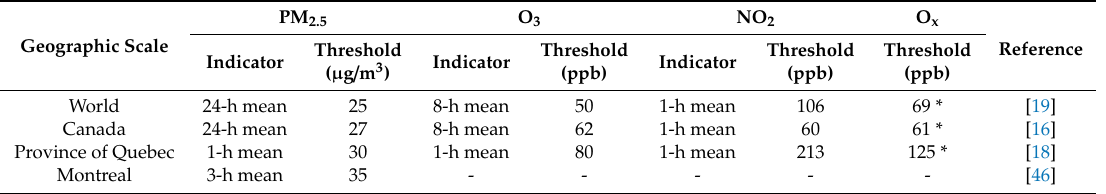
Table 4. Sample of indicators and threshold guidelines from di ff erent organizations. * estimated values of O x based on the guideline values of O 3 and NO 2 using the formula of Section 2.1. PM Geographic Scale